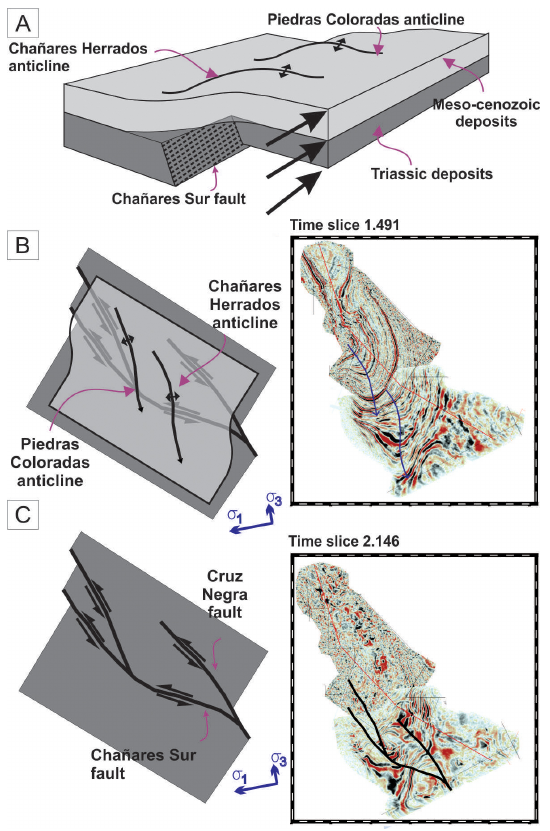
Figure 11. (a) Kinematic interpretation of the Chañares Herrados and Piedras Coloradas anticlines. These faults were developed from sinistral movement of the pre-existing Chañares Sur and Cruz Ne- gra normal faults, and the uncoupling between Triassic deposits and the Meso–Cenozoic cover. This uncoupling is clearly observed at different levels of depth in the 3-D seismic data. (b) Time slice 1.491ms from 3-D seismic data and interpretation of the gene- sis of the anticline. (c) Time slice 2.146ms and interpretation of pre-existing Triassic normal faults reactivated as sinistral strike-slip